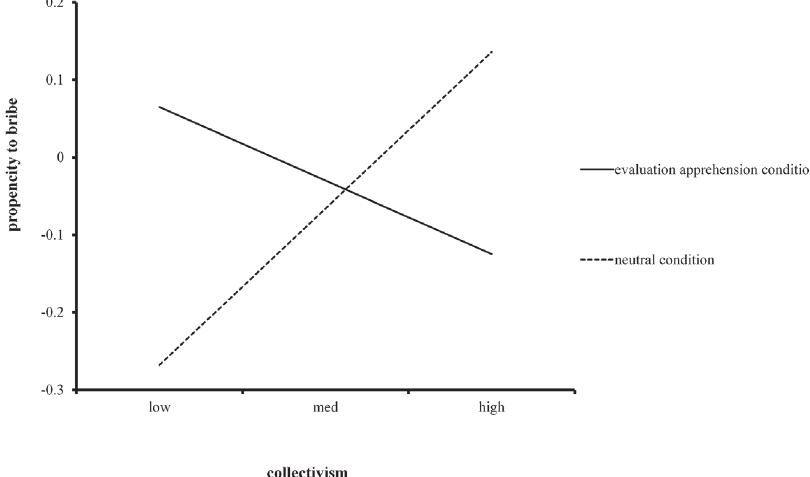
Fig 1. Evaluation apprehension moderates the relationship between collectivism and